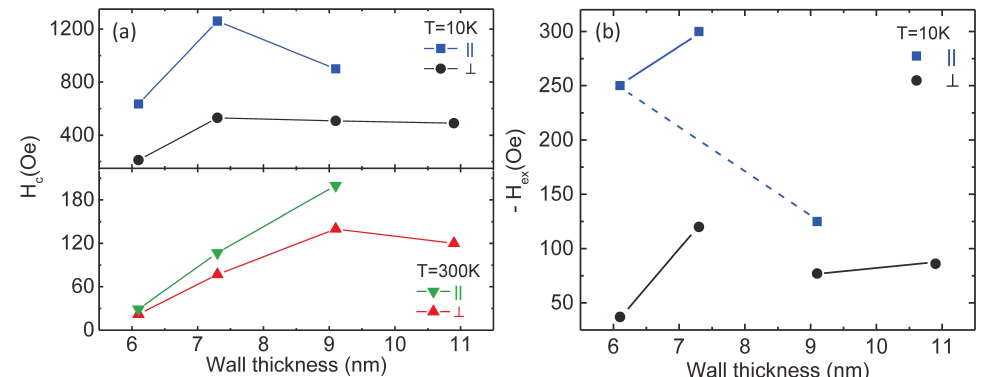
Figure 10. Magnetic parameters taken from Superconducting Quantum Interference Device (SQUID) measurements: ( a ) coercive fields determined at 300 K and 10 K in parallel and perpendicular geometry and ( b ) exchange bias fields of the analyzed samples at 10 K, where the solid lines show the cases when the H ex increases with AF layer thickness, while the dashed lines highlight the situation when H ex decreases with F layer